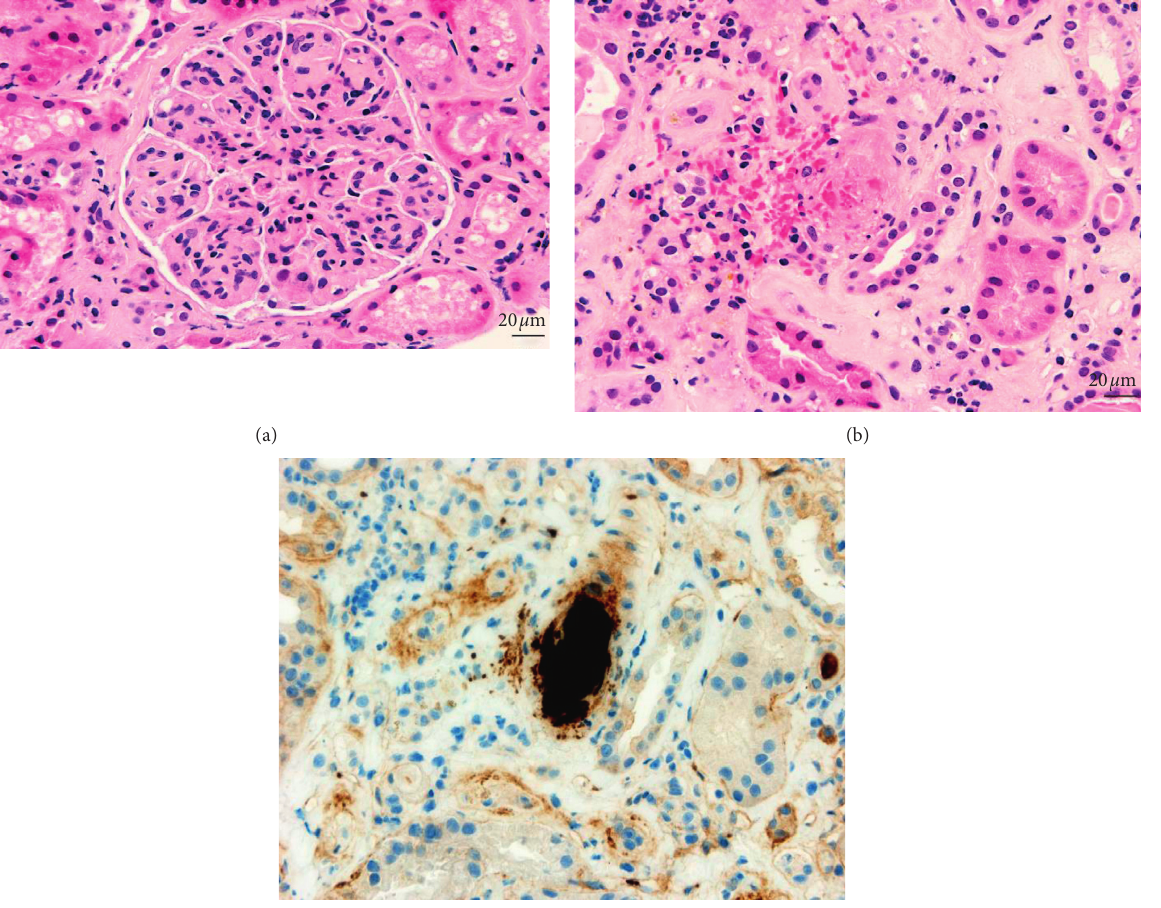
Figure 1: All the glomeruli displayed membranoproliferative features, with increased cellularity and a lobular pattern (a) (H-E, 400x). A single arteriole showed a luminal thrombus, composed of fibrin and platelets, together with blood extravasation and karyorrhectic debris